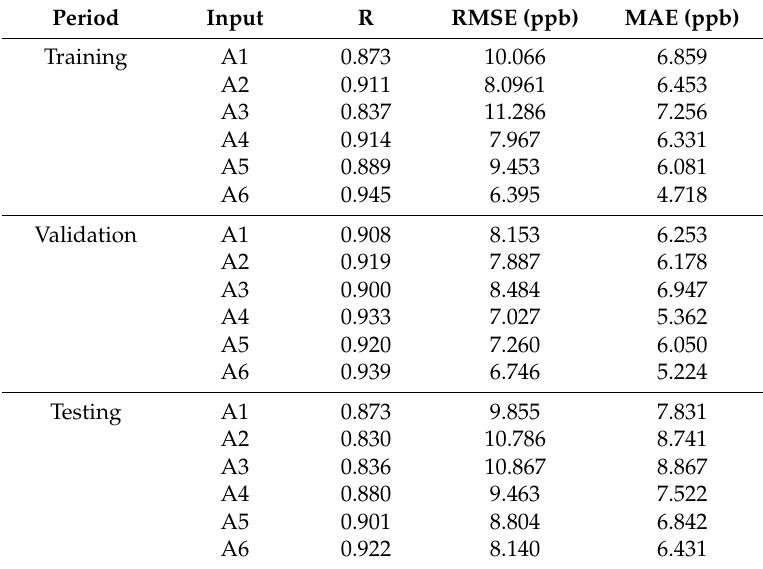
Figure 12. Scatter plot of O 3 for the ANFIS calibration model and the reference instrument for the testing periods in Figure 11. Table 5. Statistical comparison between O 3 measurements from reference instrument and EC sensor OX signal calibrated using the ANFIS technique. Results are presented for the training, validation and testing